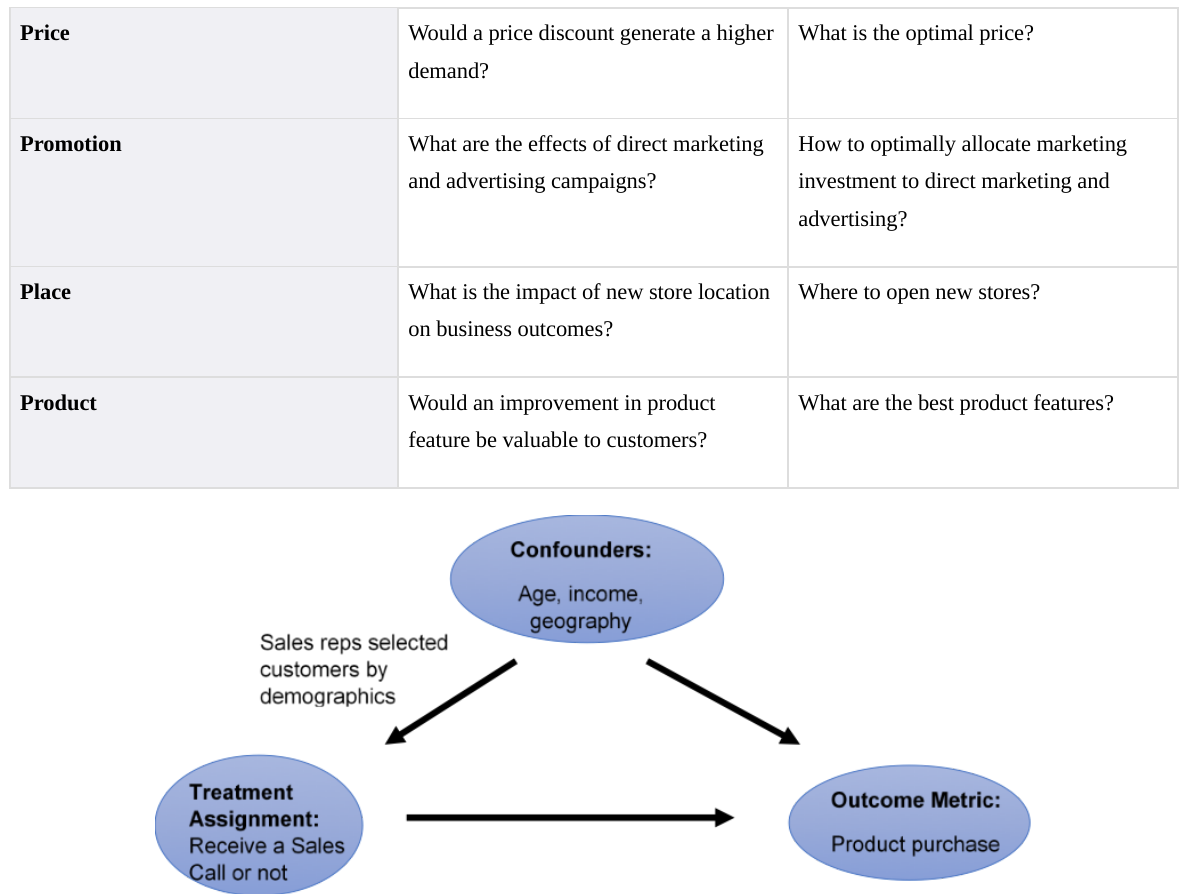
Figure 3. Sales Measurement using Observational